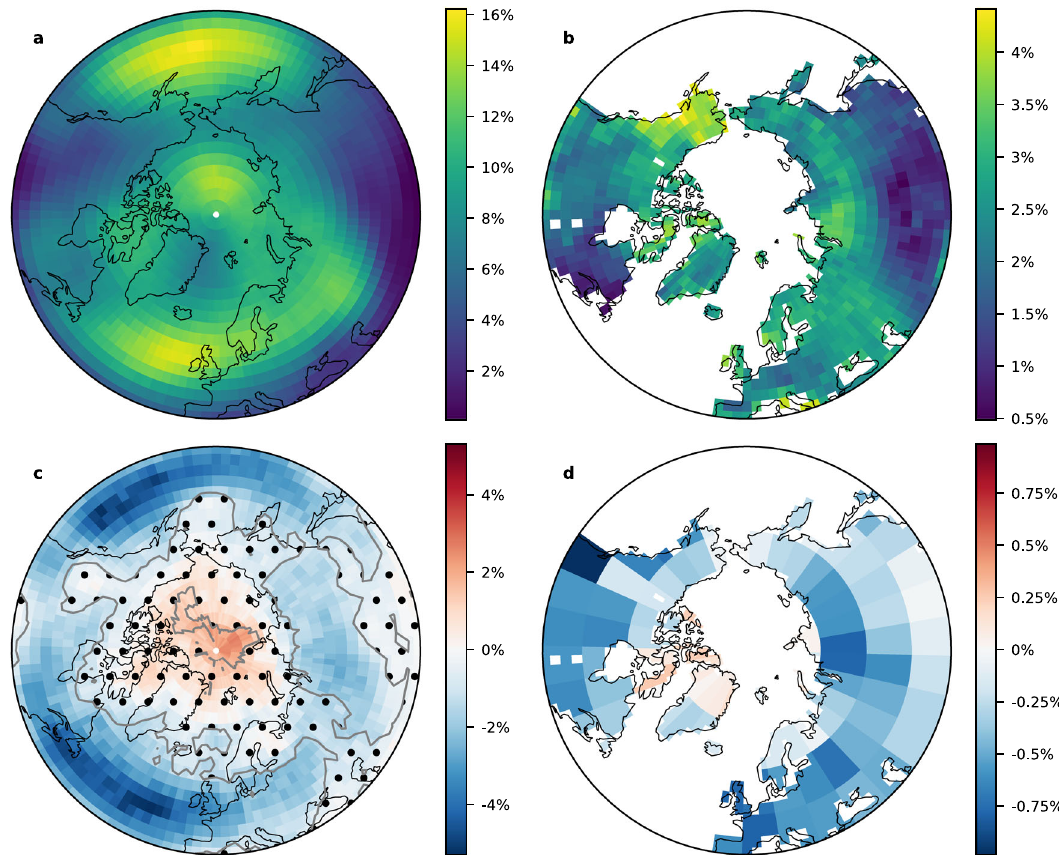
Fig. 3 Spatial projection of summer blocking and heatwaves. a , b The multi-model-mean historical (1966 – 2005) frequency of blocking ( a ) and heatwaves ( b ). c , d The multi-model-mean frequency change, in SSP585 (2060 – 2099) minus historical, of blocking ( c ) and heatwaves ( d , counting only the effect of blocking changes). Dots enclosed in grey contours in c denote regions where the changes are NOT statistically signi fi cant.